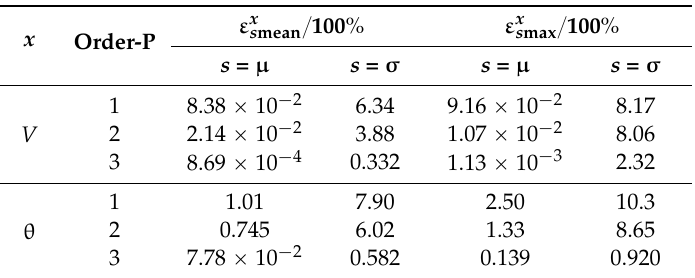
Table 2. Mean and maximum of ER of SG-PLF under 1-3